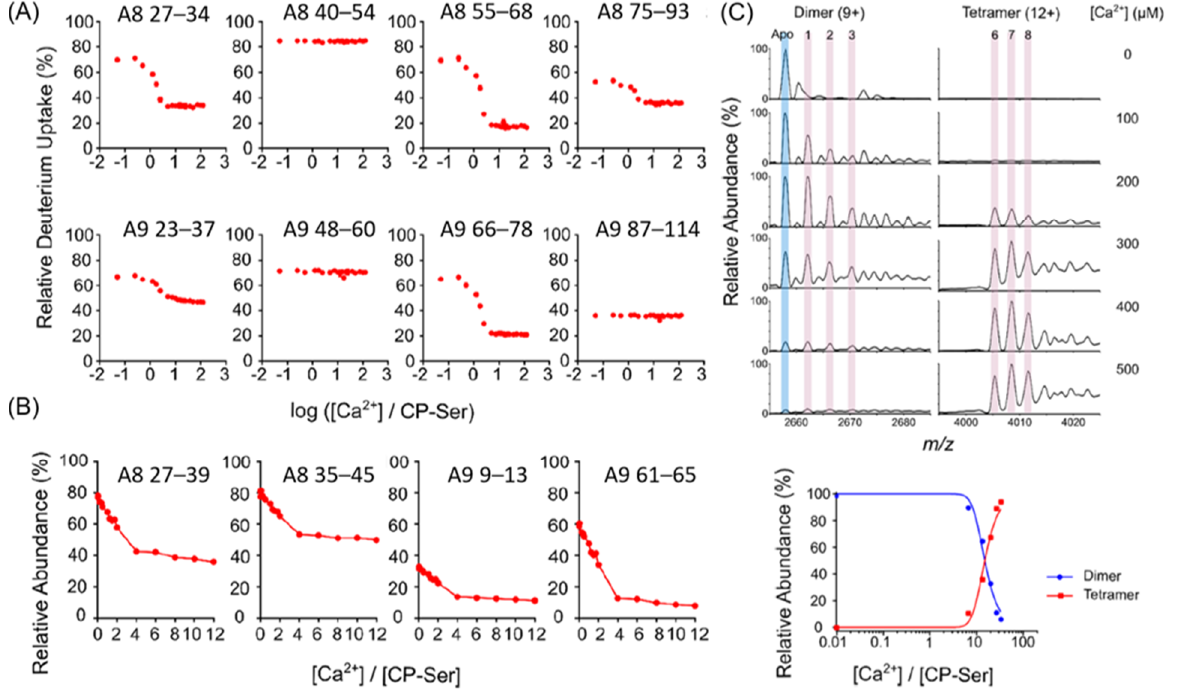
Figure 5. Titration MS results of Ca 2+ binding to CP-Ser. ( A ) Peptide level PLIMSTEX results for the S100A8 and S100A9 subunits. ( B ) Peptide-level sharp-break PLIMSTEX results. ( C ) Native-MS titra- tion results of the most abundant charge state of dimer/tetramer. The abundance of dimers/tetramers was normalized and plotted as a function of [Ca 2+ ]/[CP-Ser]. Reproduced with permission from Ref. [70]. Copyright 2020 American Chemical